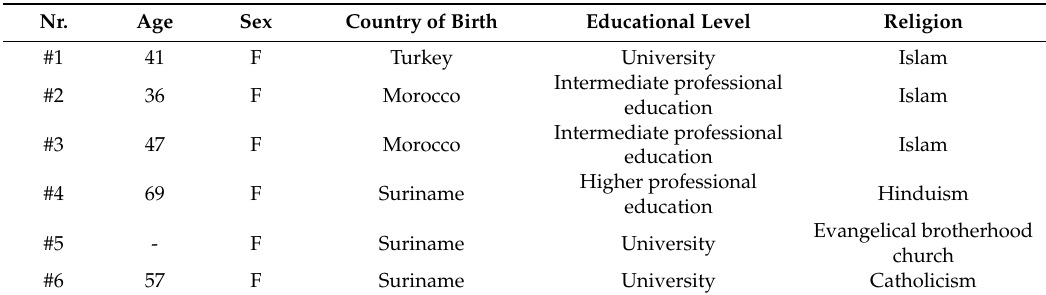
Table 2. Characteristics of